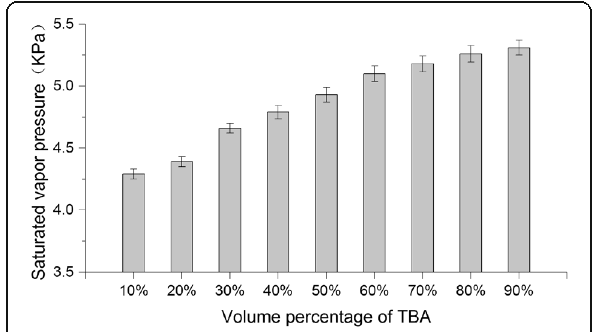
Fig. 5 Saturated vapor pressure of TBA/water co-solvent with different volume percentage (mean ± SD, n =